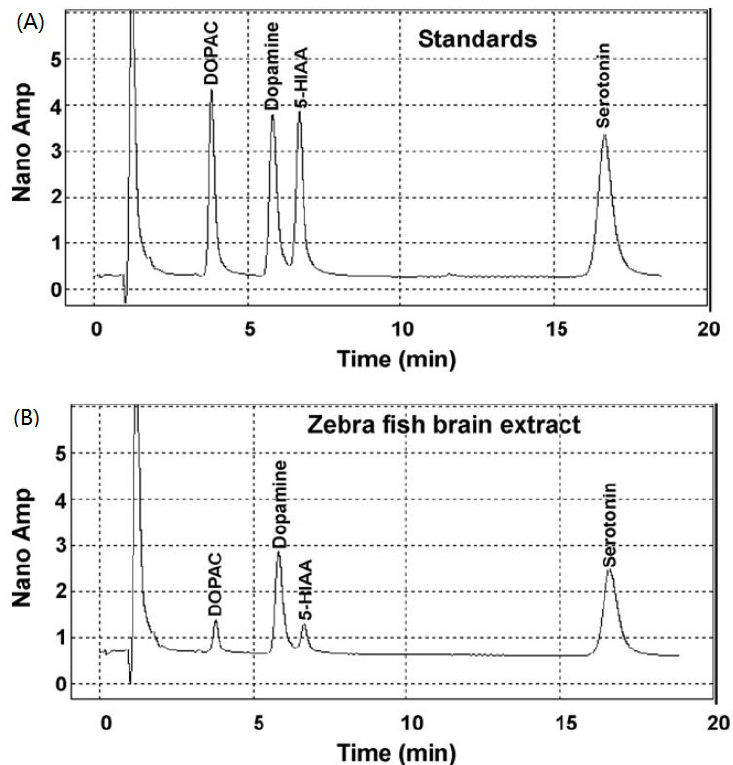
Figure 6. HPLC analysis of some neurotransmitters; chromatogram of neurotransmitters separated by the microbore HPLC column. ( A ): standard DOPAC (50 pg), dopamine (150 pg), serotonin (100 pg) and 5-HIAA (50 pg); ( B ): DOPAC, dopamine, serotonin and 5-HIAA separated from zebrafish brain lysate